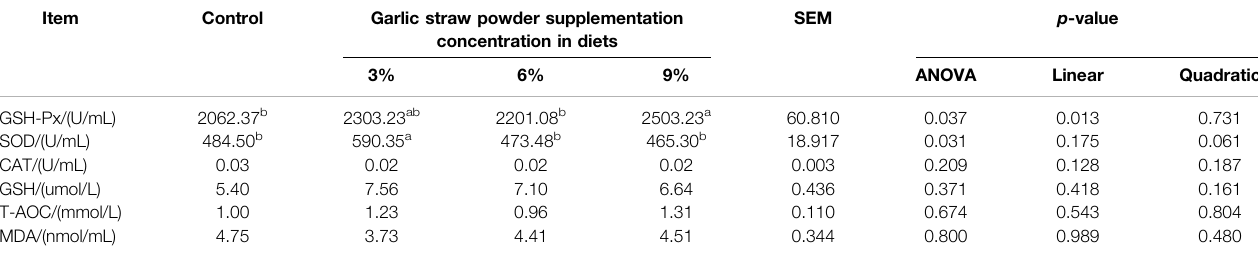
TABLE 5 | Effects of different dietary levels of garlic straw powder on serum antioxidant performance in yellow-feathered broilers. Item Control Garlic straw powder supplementation SEM p -value concentration in diets Quadratic